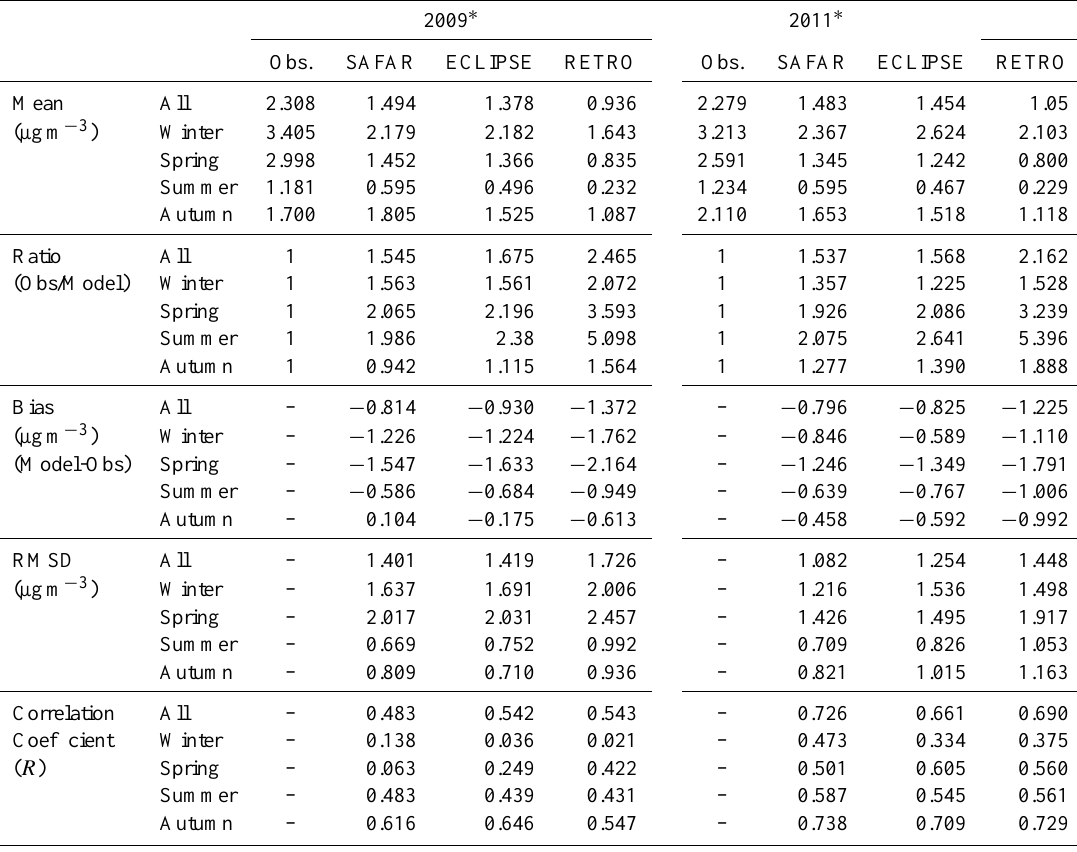
Table 2. Average, ratio, bias, RMSD and correlation coefficient between modelled and observed BC concentrations when using different inventories for the years 2009 and